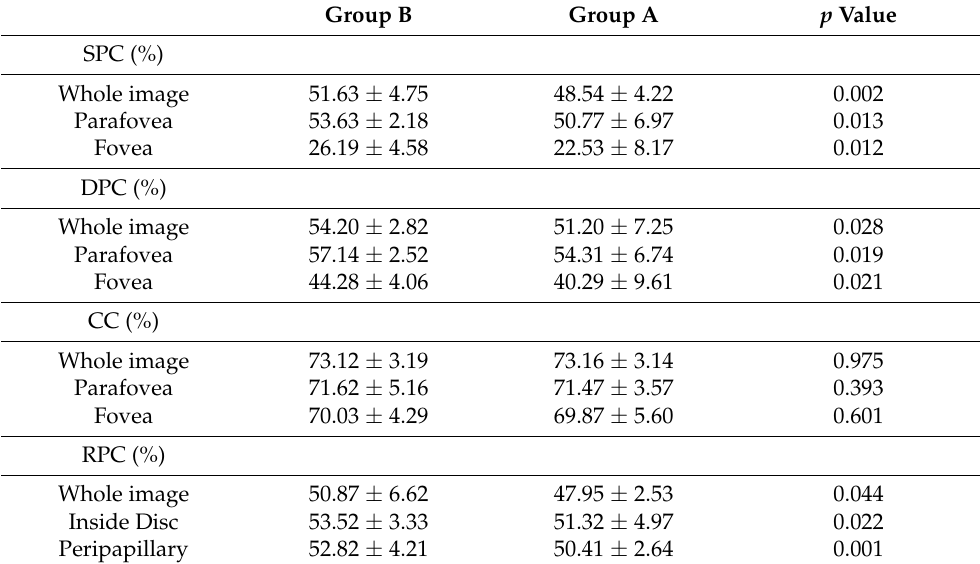
Table 3. Differences in OCT angiography vessel density between controls and patients.